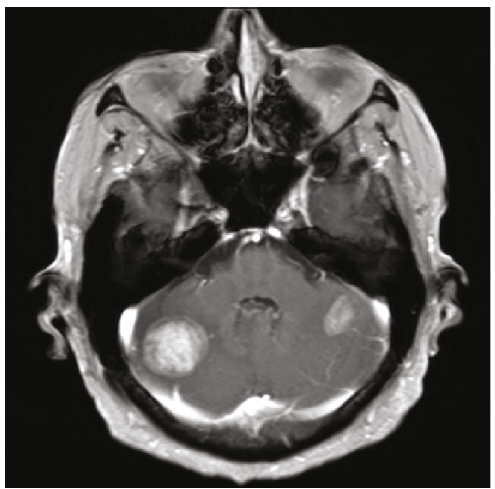
Figure 3: CT imaging of the head demonstrated brain